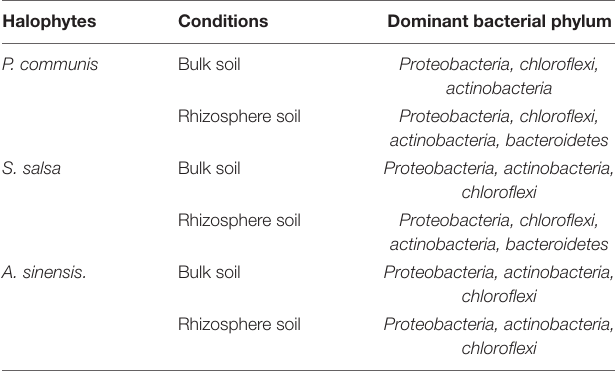
TABLE 2 | The dominant phyla in the rhizosphere and bulk soil of different